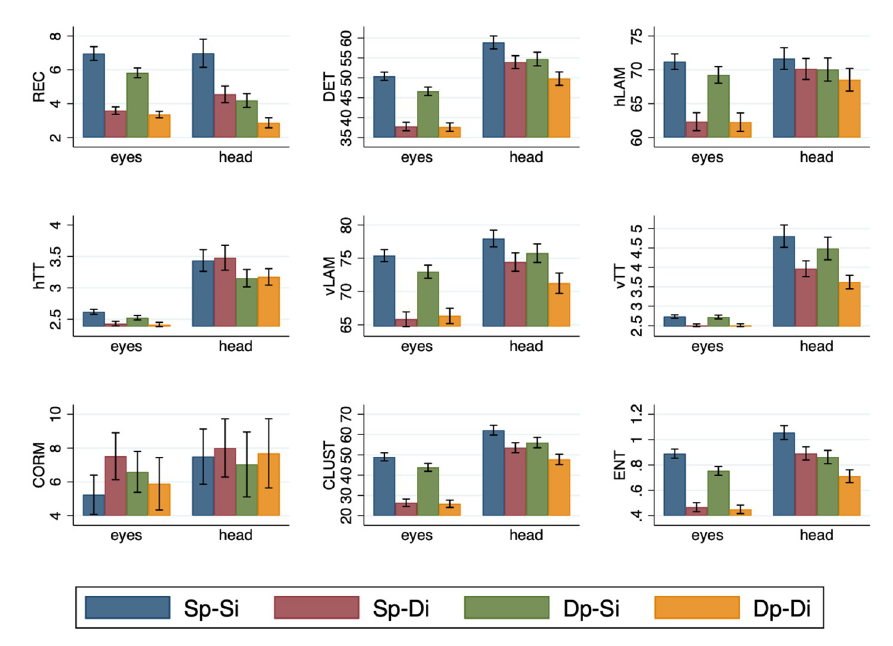
Fig 7. Scanpath similarities for eyes and head measured using nine CRA measures. Scanpath similarity values for eyes and head are shown for the four conditions (Sp-Si, Sp-Di, Dp-Si, Dp-Di) and the nine CRA measures (REC, DET, hLAM, hTT, vLAM, vTT, CORM, CLUST and